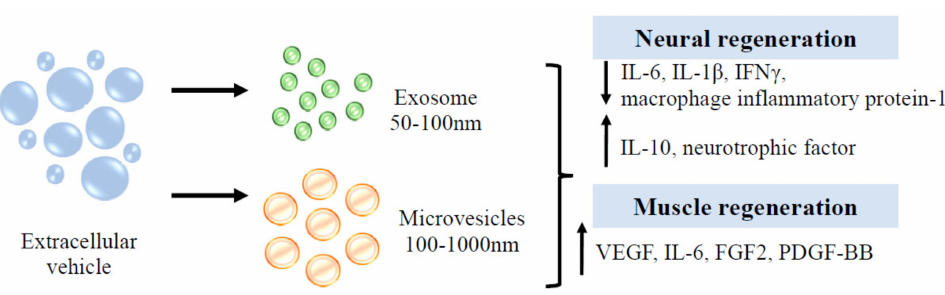
Figure 6. WJMSC functions. ( a ) The function of WJMSCs in neuronal and muscular regeneration. ( b ) Immunomodulatory properties of WJMSCs in preventing fibrosis.